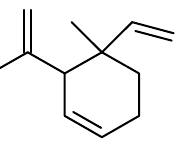
Figure 3. Structure of geijerene.